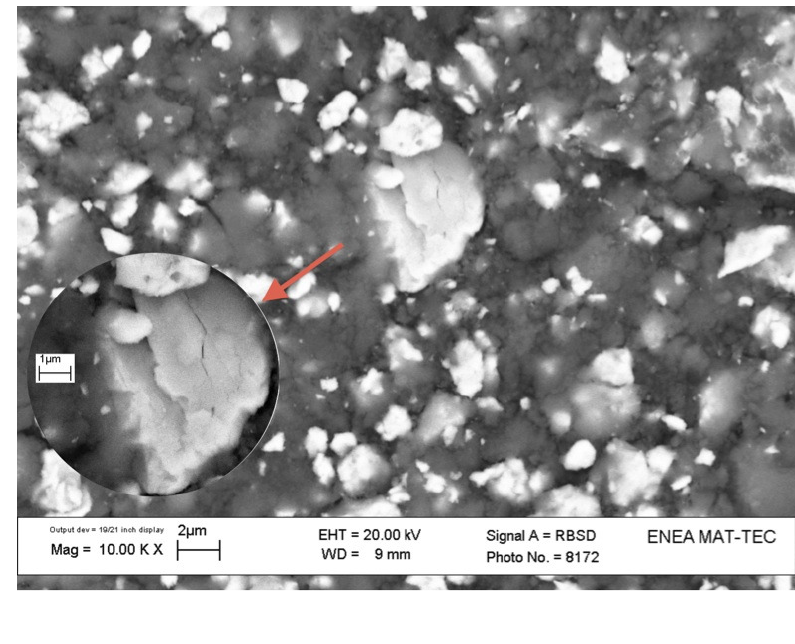
Figure 11. Pictures of LaNi -SiO | composite pellet after 40 hydrogenation/dehydrogenation 5 2 300 cycles (pH = 10 bar). In the inset, a fractured metal particle is fixed in the 2